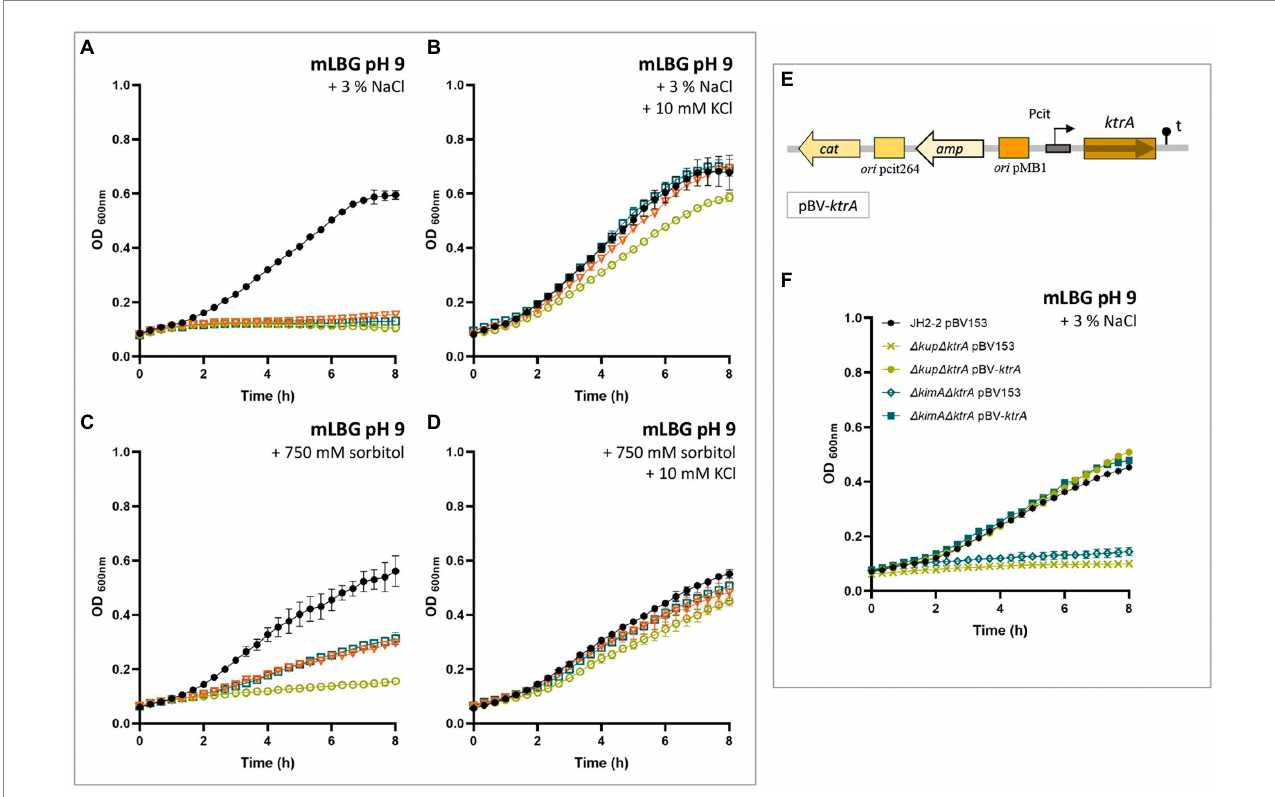
FIGURE 5 KtrA contributes to the osmotic response in Enterococcus faecalis . Wild type (black dot), Δ ktrA (light blue square), Δ kup Δ ktrA (yellow circle), and Δ ktimA Δ ktrA (orange triangle) strains were grown in mLBG at alkaline initial pH and supplemented with 3% NaCl (A) or 750 mM sorbitol (C) . In both growth conditions, the addition of 10 mM KCl ( B and D , respectively) completely restored defective strains growth to near wild-type levels. (E) Schematic representation of the plasmid pBV- ktrA used for complementation of a full copy of the wild type ktrA gene. (F) Expression of ktrA from a pBV153 fully complemented the growth defects of the KtrA-mutant strains in mLBG at alkaline initial pH and supplemented with 3% NaCl, and in all conditions tested in this study (data not